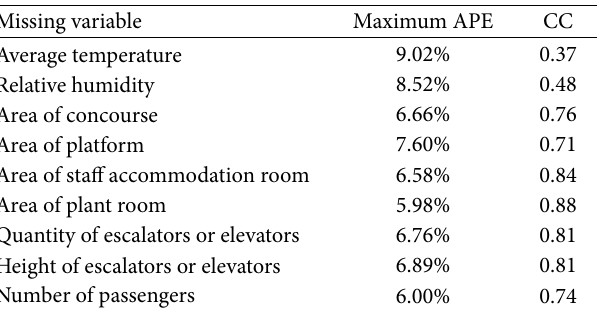
Table 8: Impact of influence factors on model prediction